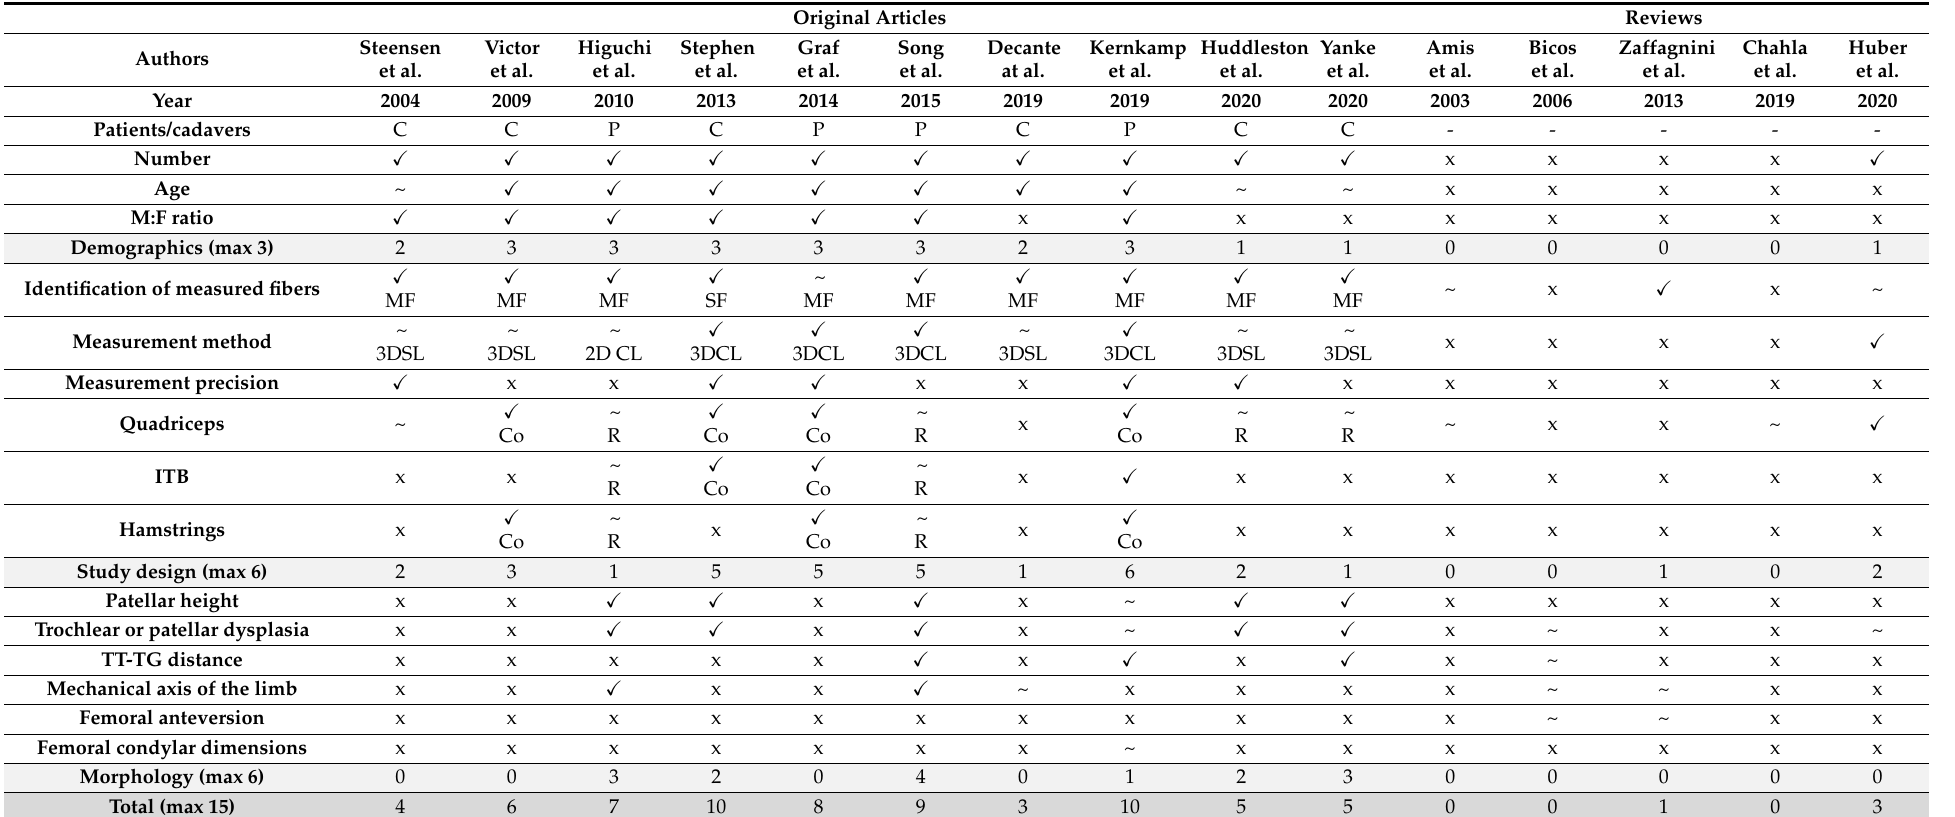
Table 5. Summary of which sources of heterogeneity were reported in included